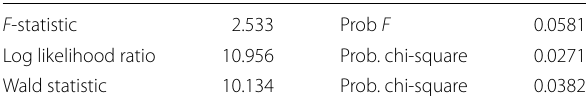
Table 4 Chow breakpoint test